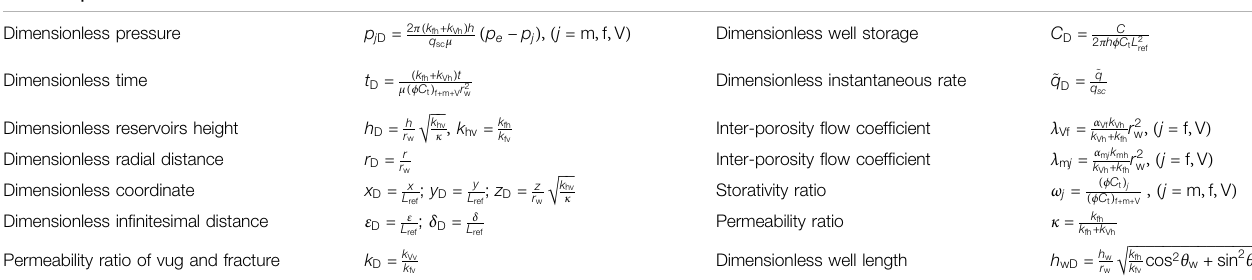
TABLE 1 | Dimensionless variables de fi nition. Dimensionless pressure